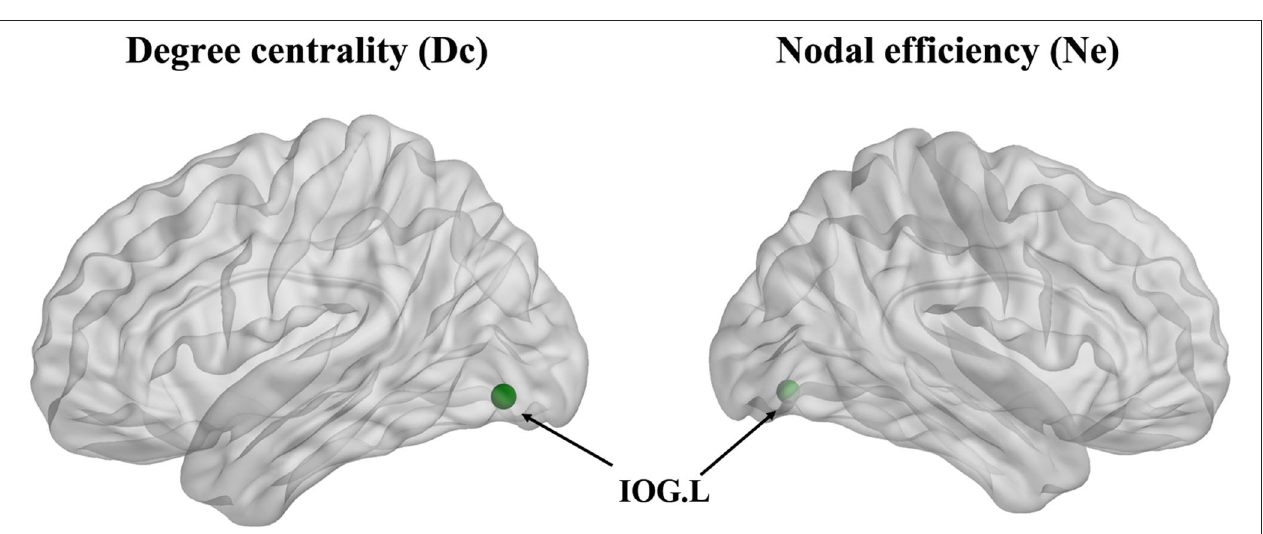
TMT-B score ( p < 0.05). Significant differences in other cognitive performances were not